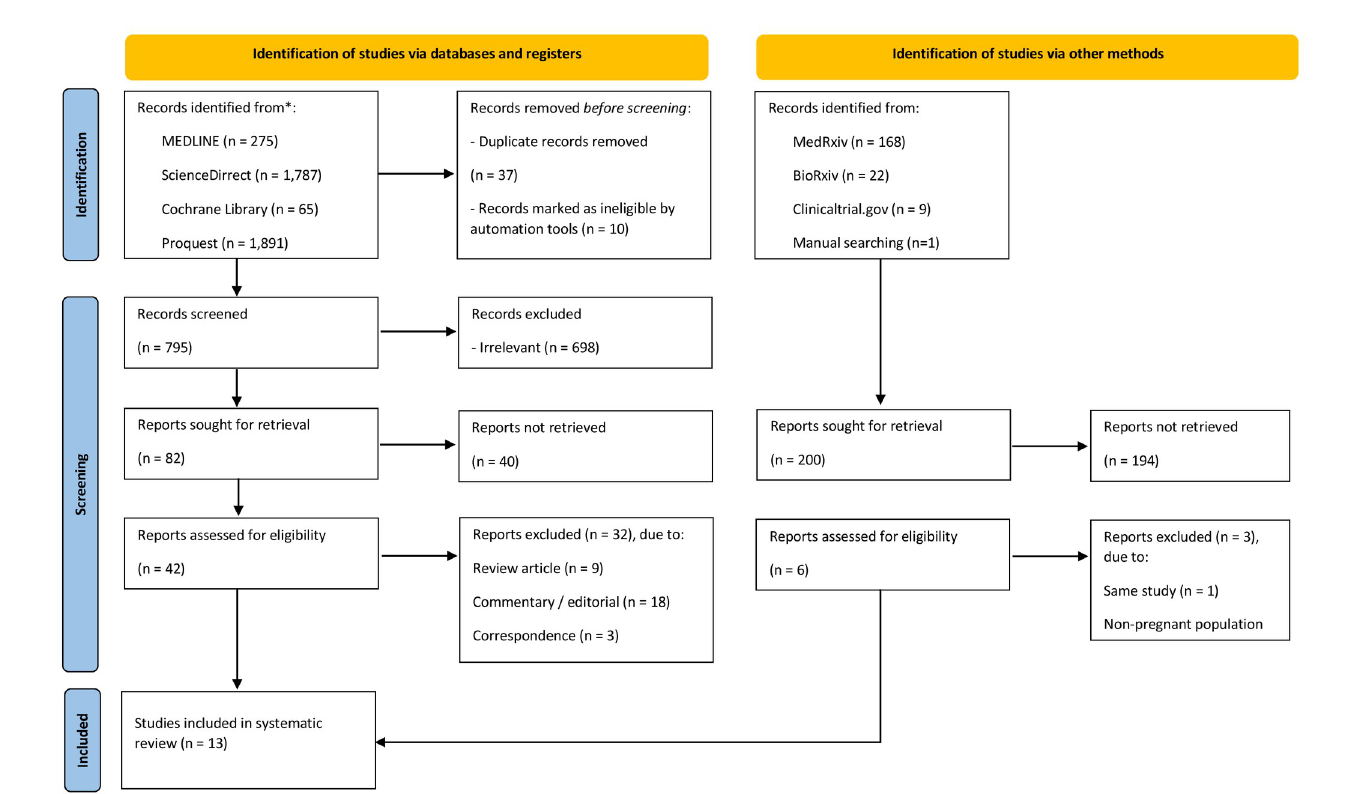
Fig 1. PRISMA flow diagram of study selection